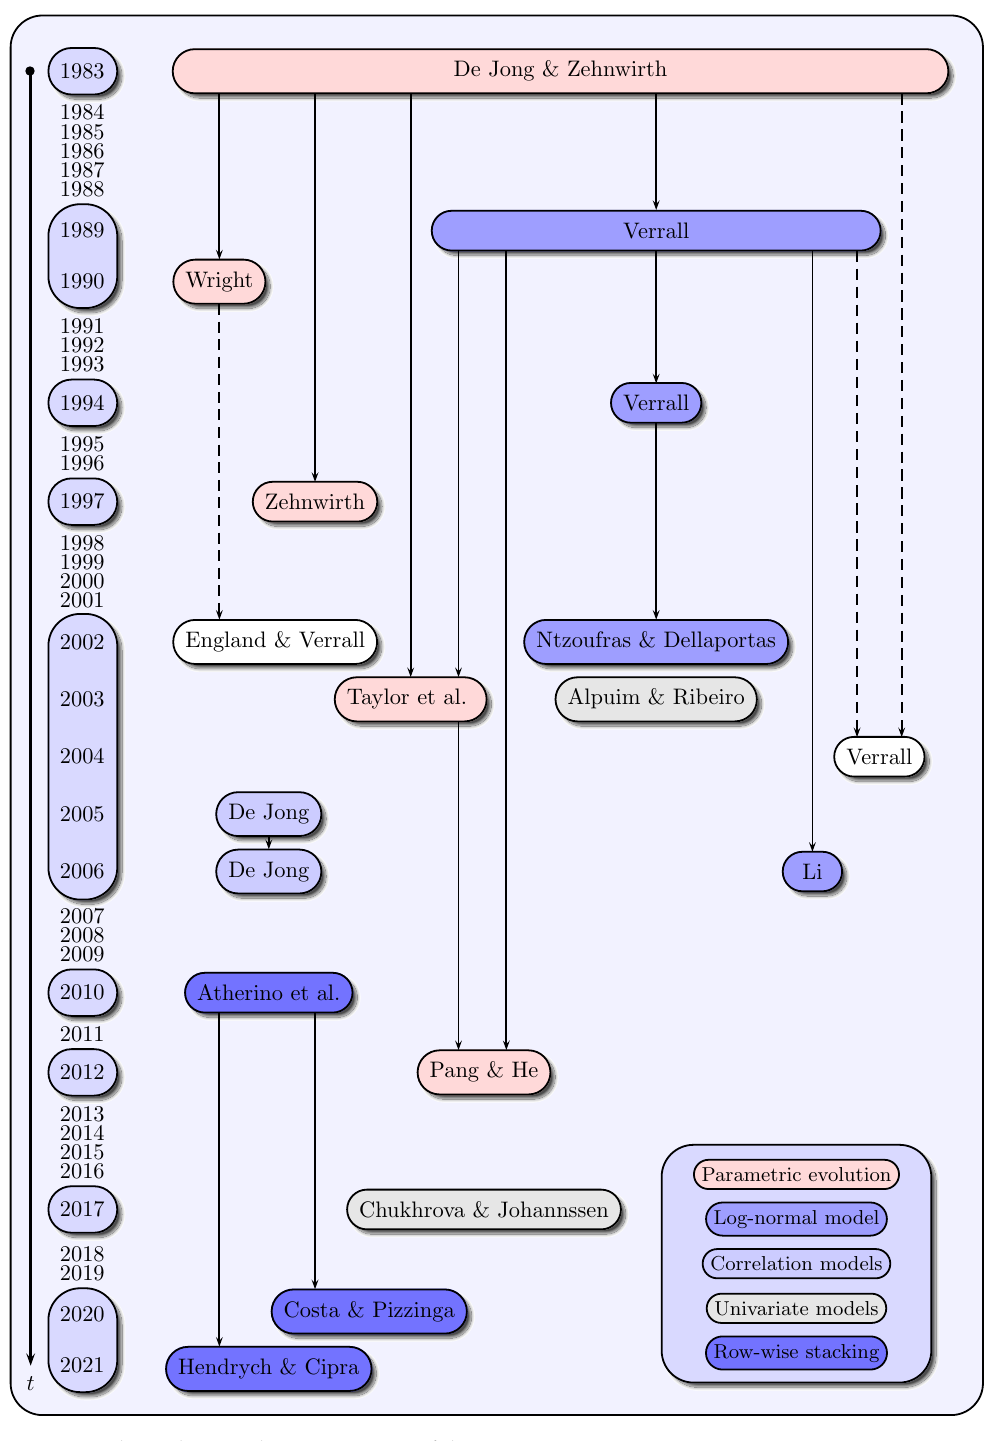
Figure 1. Chronology and categorization of the